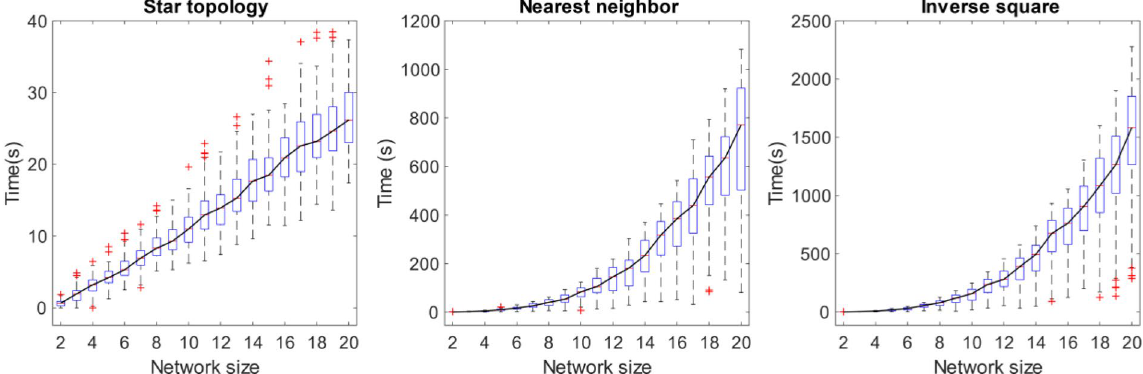
Figure 8. Increase in time to AP synchronization. The time taken to AP synchronize increases with network size for network topologies where antiphase synchronization is possible. The variance of the time increases as well as shown by the boxplot. The solid line connects the median time required. The box bounds the 75th percentile and the plus markers indicate the outliers.